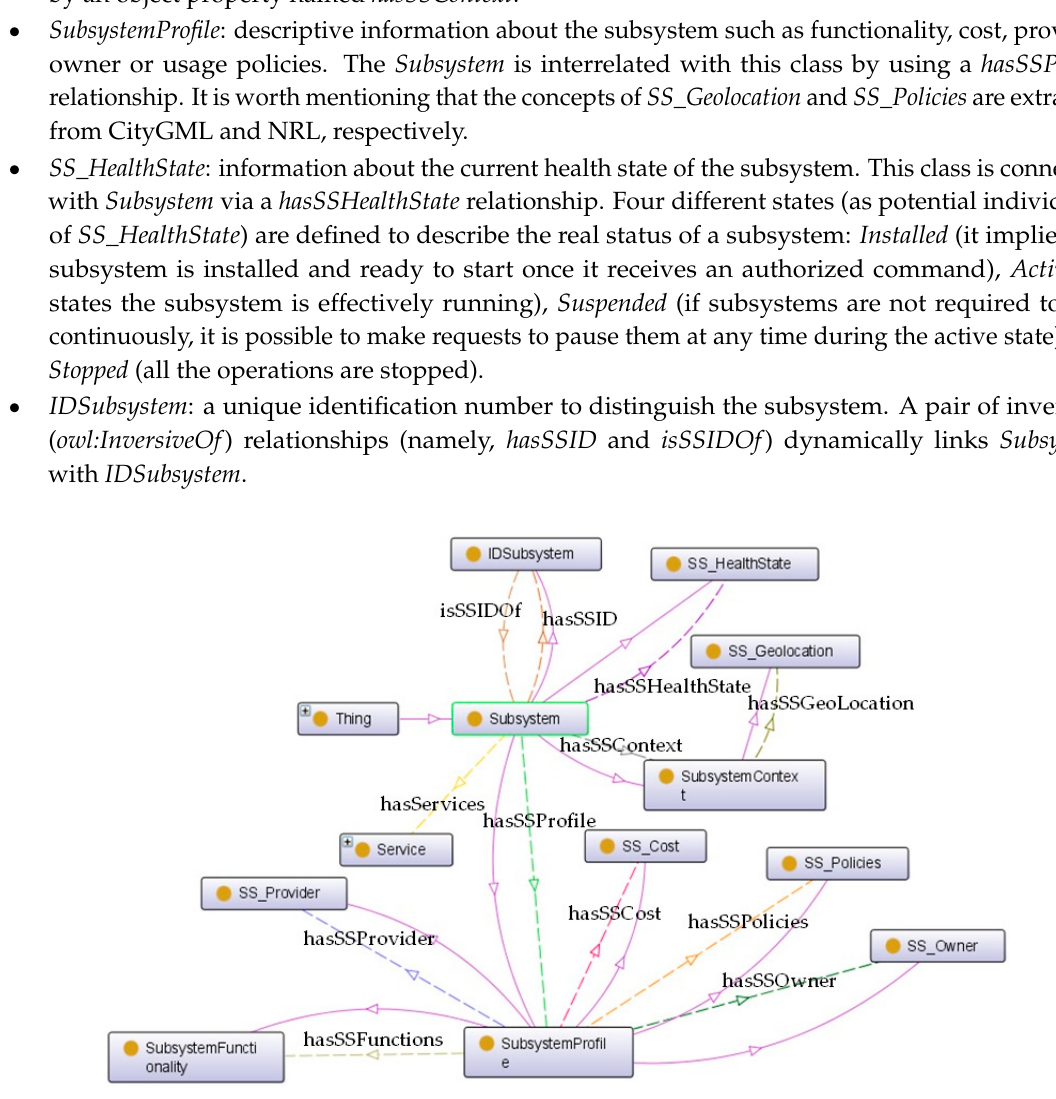
Figure 5. The internal structure of Subsystem.